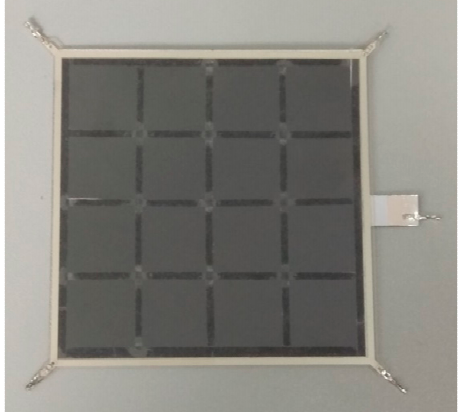
Figure 9. The sensor sample.